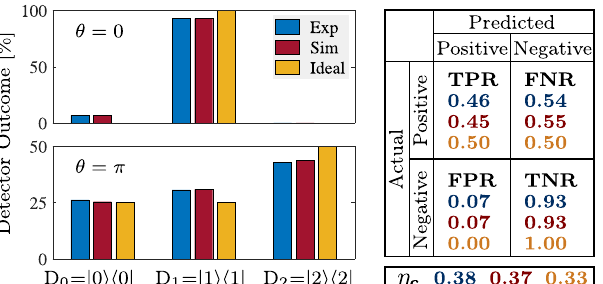
Fig.3|Histogramofeventsfor θ = π and N =1,andthecorrespondingconfusion matrixandef fi ciency. (leftpanels)Histogramofeventsrecordedbythedetectors D 0 , D 1 , and D 2 , which are modeled as projectors. Histograms resulting from the experiments, simulations and ideally expected values are shown in blue, red and yellow colors respectively. The results are obtained from 10 6 realizations of the experiment, and for B -pulse strengths θ =0, π . The percentage outcome at D 0 corresponds to successful interaction-free detection, D 2 represents the number of times the pulse is absorbed, and D 1 are the inconclusive instances. (right panel) Confusion matrix and ef fi ciency η c for the detection of π pulses showing the experimental (blue), simulated (red) and ideally expected (yellow) values.